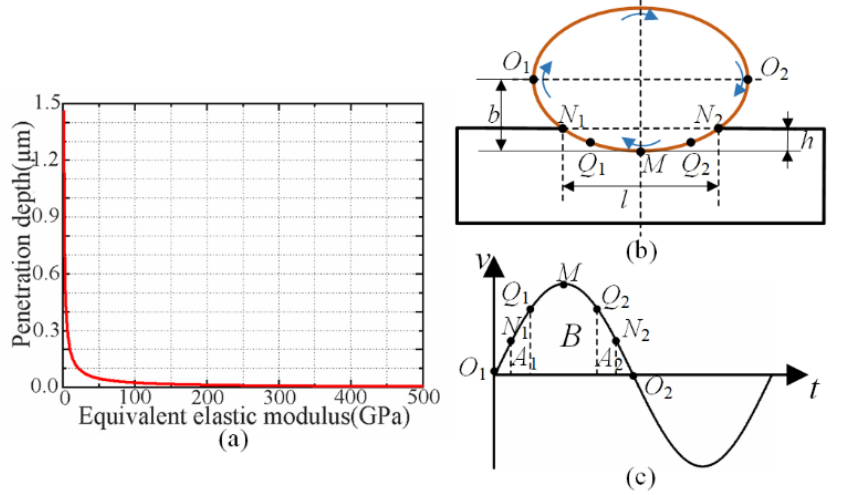
Figure 7. Micro-mechanism analysis. ( a ) Relationship between pressuring depth and equivalent elastic modulus. ( b ) Stator and mover micro-drive model. ( c ) Horizontal movement speed of the driving point.